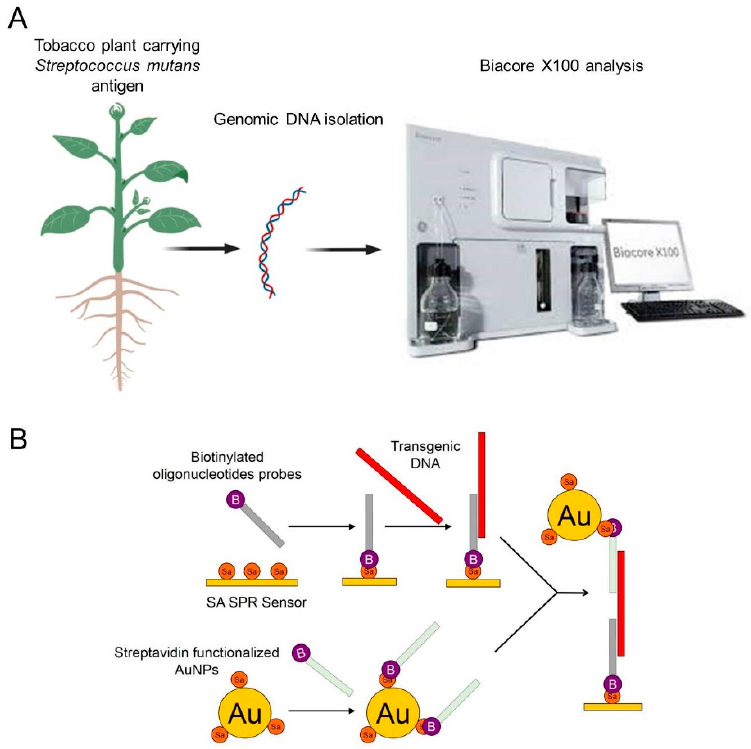
Figure 1. Schematic presentation of the experimental procedure. (A): general procedure of detection of transgenic plant using AuNPs based SPR biosensor, (B): schematic presentation of transgenic DNA detection using SA SPR sensor and AuNPs.